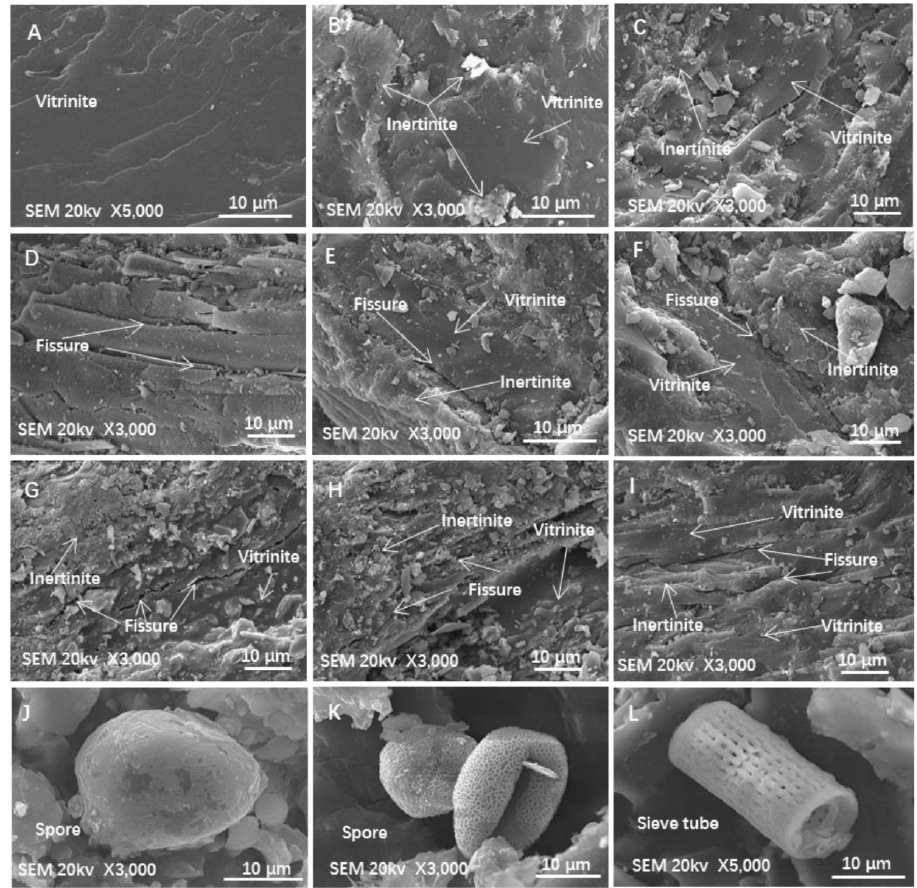
Figure 9. Representative SEM images of samples pretreated by liquid nitrogen quenching. ( A – C ) Liberation characteristics of products from coal with a particle size greater than 0.9 mm; ( D – F ) liberation characteristics of products from coal with a particle size between 0.5 and 0.9 mm; ( G – I ) liberation characteristics of products from coal with a particle size between 0.1 and 0.5 mm; ( J – L ) liberation characteristics of products from coal with a particle size less than 0.1 mm.